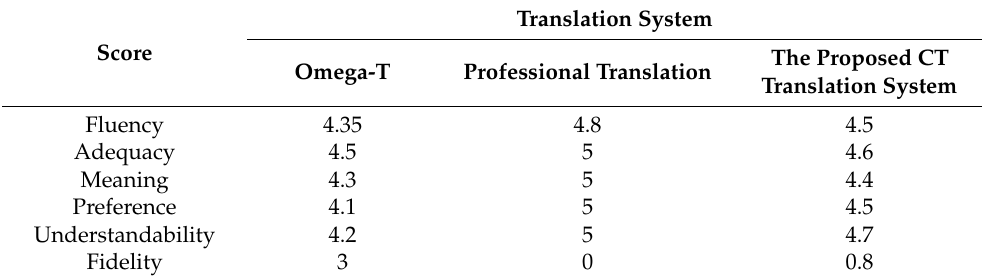
Table 1. Manual evaluation of the translation quality, for the English-Arabic corpora.